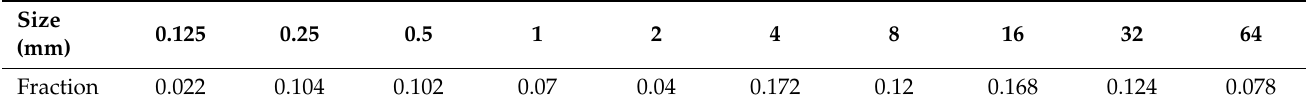
Table 2. Input sediment mixture for the bed aggradation experiment (Seal et al. [32]).